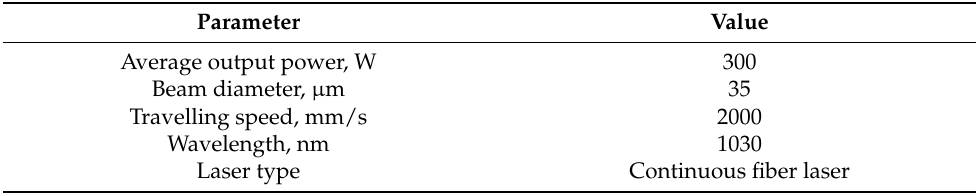
Table 4. Main parameters for laser joining of Ti6Al4V and CCF30/PEEK.